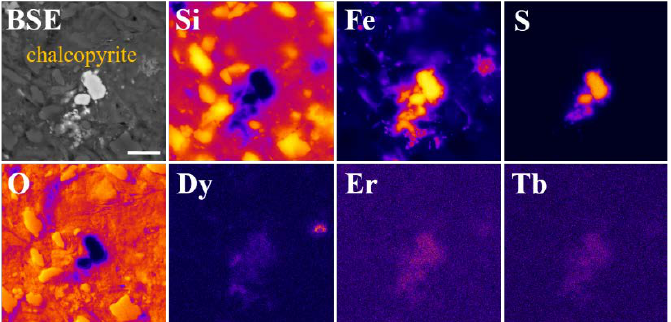
Figure 6. EPMA-WDS quantitative elemental mapping of Pittsburgh underclay (UC-07). Scale bar is 10 microns. Analysis conditions 20 keV, 45 nA, map dwell time = 250 ms.